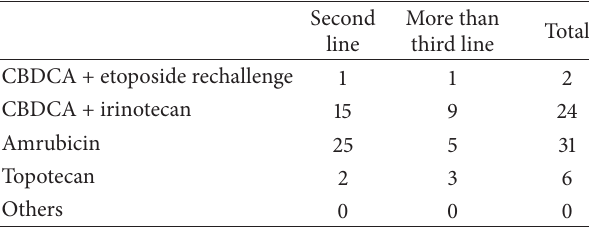
Table 2: Chemotherapy regimens administered following disease progression after the first-line